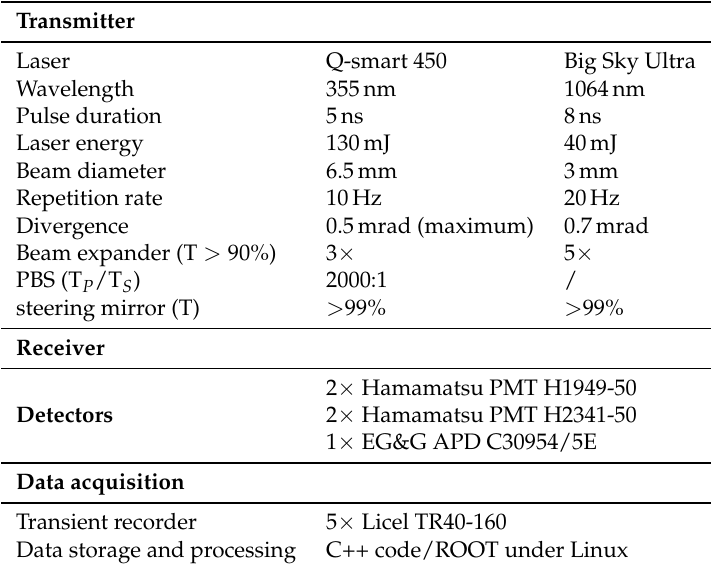
Table 1. Main components of the polarization Raman–Mie LiDAR. PBS: Polarization Beam Splitter, PMT: Photomultiplier Tube, APD: Avalanche Photodiode.